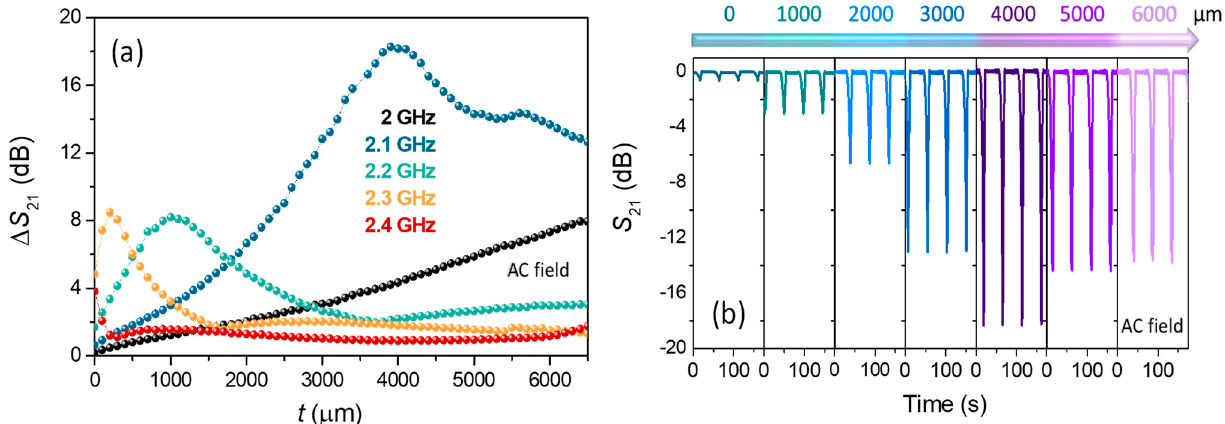
Figure 7. AC magnetic field experiments performed in the sensor array platform configuration 2 of Co-based MWs: ( a ) the ∆ S 21 trends with the overlapped thickness placed on the top of the Co-based MWs at fixed frequencies ranged from 2.00 GHz to 2.40 GHz; ( b ) time-resolved modulation of the scattering coefficient ∆ S 21 due to an AC-bias magnetic field ( H AC = 17 Oe, f AC = 10 Hz) and a fixed electromagnetic microwave frequency of 2.10 GHz as a function of the thickness of polymeric slabs ( t ) overlapped from 0 to 6000 µm.